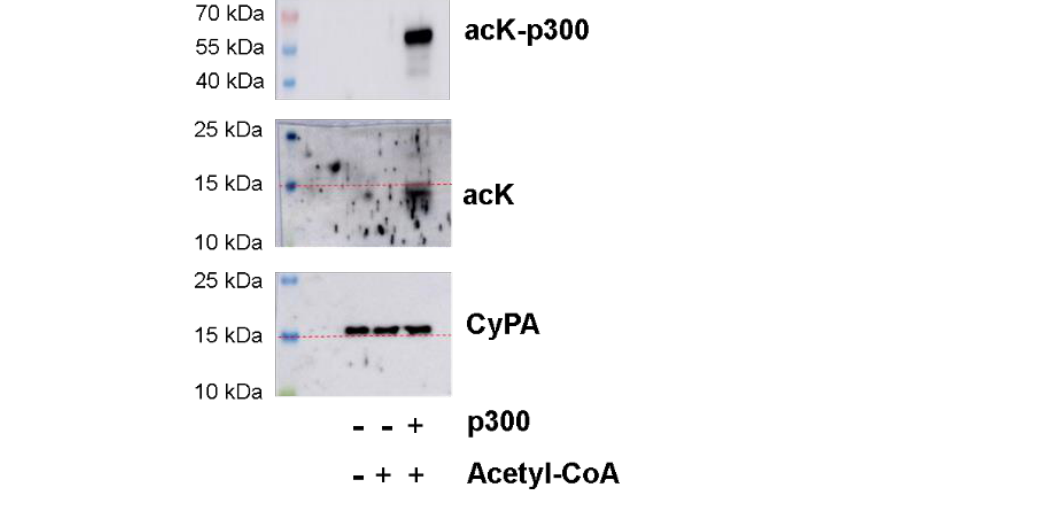
Figure 2. In vitro acetylation of Cyclophilin A by acetyltransferase p300. Recombinant human CyPA was incubated with acetyltransferase p300 in the presence or absence of acetyl-CoA for 30 min. Samples were separated on a 13% acrylamide gel and processed for CyPA and lysine acetylation (acK) Western blots. Mainly auto-acetylation of p300 was observed. The acetylated band at 14 kDa (below red line) was not detected by CyPA antibody (16 kDa, above red line). The experiment was repeated three times with similar results.